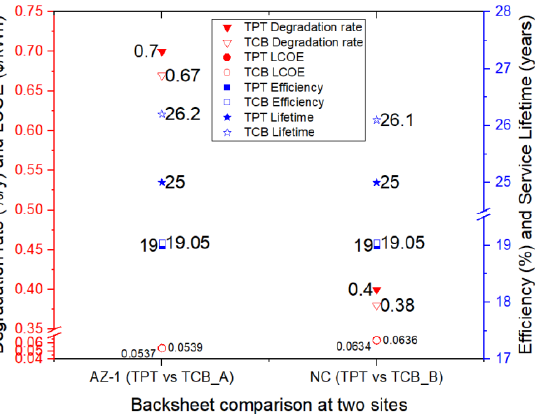
Figure 9. LCOE analyses’ key parameter comparison for TPT and TCBs at two different sites (red color legend indicates parameters on left y-axis and blue color legend indicates parameters on right y-axis).